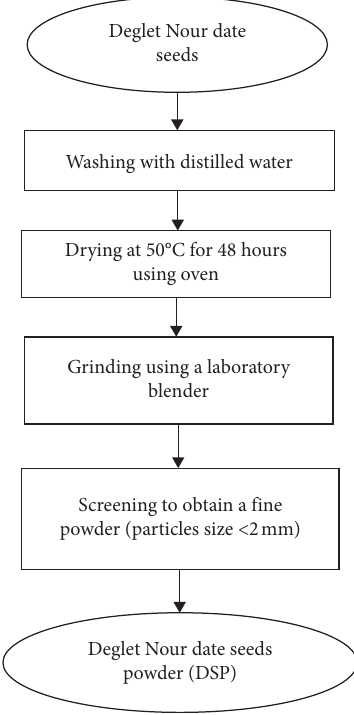
Figure 1: Preparation of Deglet Nour date seeds powder (DSP).